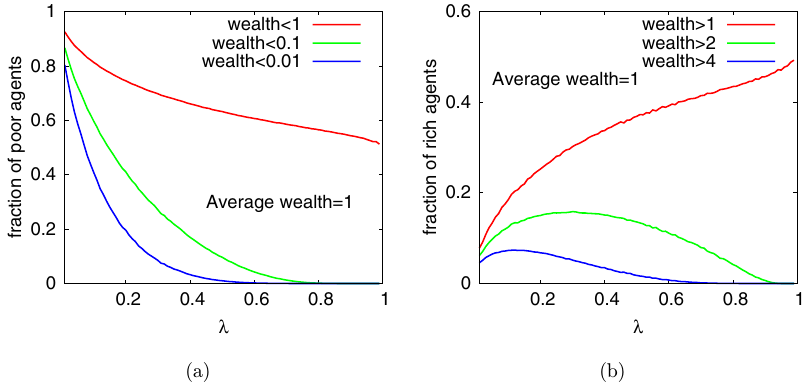
Fig. 3. For constant saving propensities, the fraction of agents having very low wealth (a) remains ¯nite for almost upto (cid:1) c (cid:2) 0 : 5 . The fraction of agents with very high income (b) also depends non-monotonically on (cid:1) . It can be seen that for low values of (cid:1) the inequality is very high.